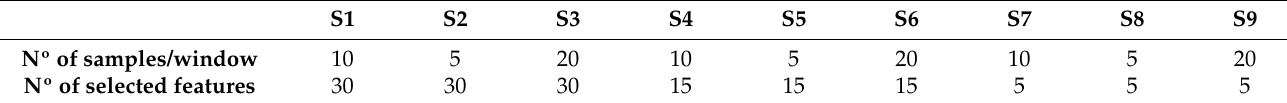
Table 3. Dataset pre-processing setup description (S1–S9).